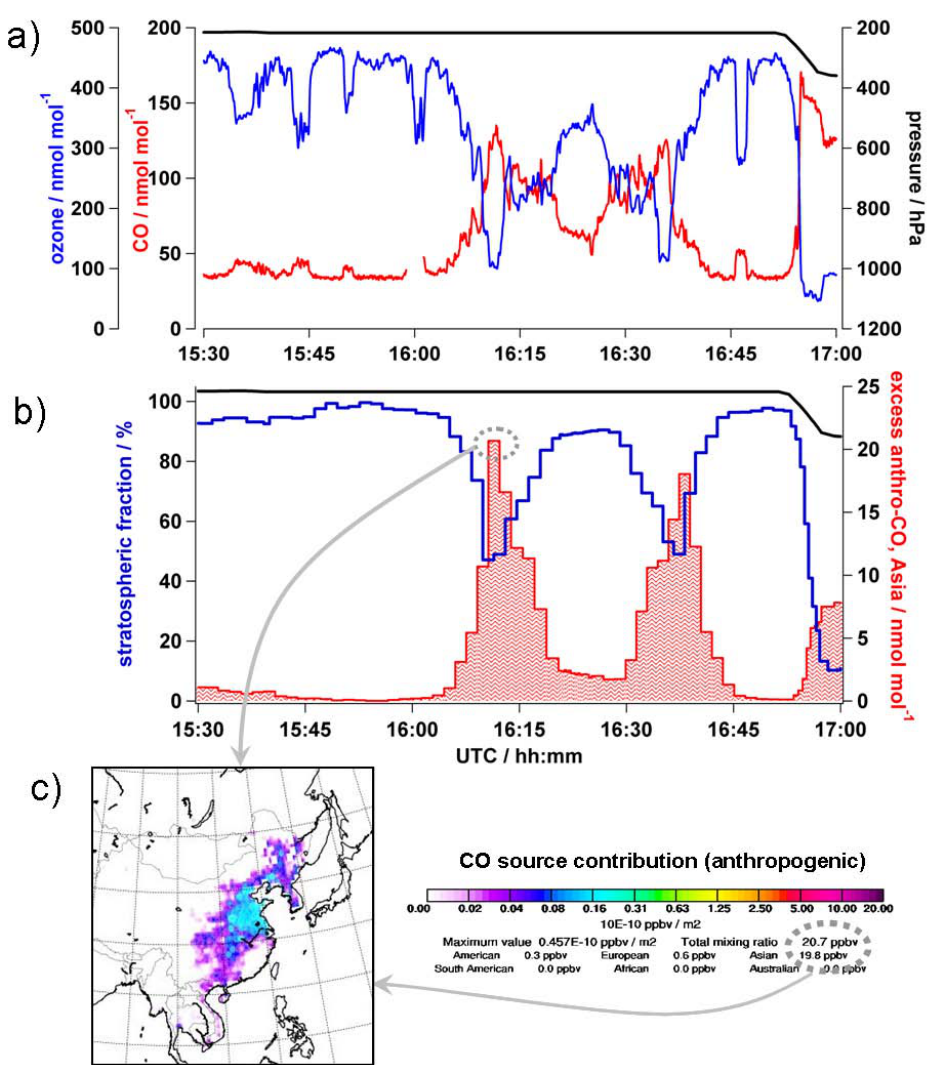
Fig. 3. (a) Time series of in-situ CO (red), O 3 (blue), and pressure at flight altitude (black) for the same time period shown in Fig. 2. (b) Results of the FLEXPART backward analysis: the blue line gives the stratospheric fraction along the flight path. The red pattern represents the FLEXPART excess-CO originating from Asian anthropogenic pollution. (c) CO source contribution plot for 16:11UTC (maximum CO concentration at 11.3km altitude) with colour-scaling on the right.